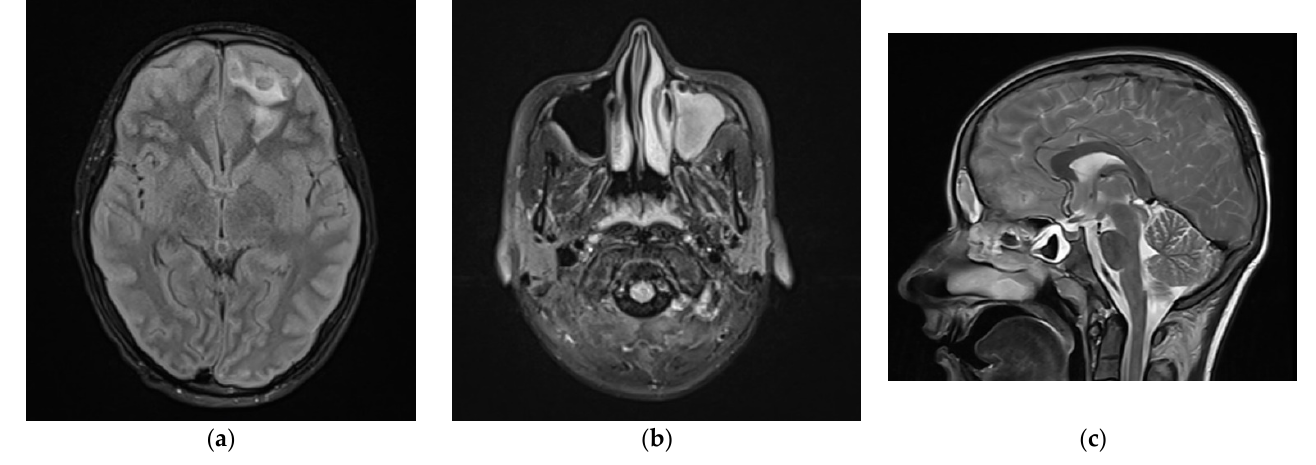
Figure 1. Magnetic resonance imaging (MRI) of the head of 10 December 2021 revealed: ( a ) in the left frontal lobe several irregular fluid areas features of intracerebral abscesses with mass effect; ( b ) massive inflammation of the left maxillary sinus; ( c ) sagittal sinus thrombosis.